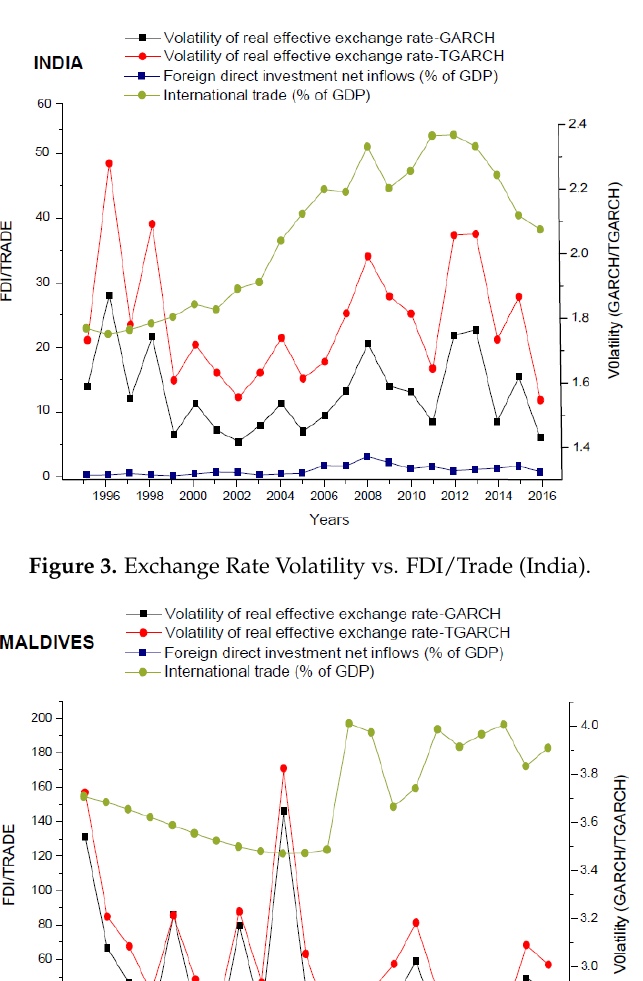
Figure 2. Exchange Rate Volatility vs. FDI/Trade (Bhutan).